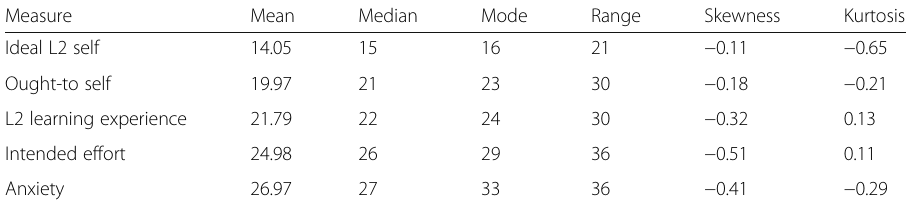
Table 2 Report of mean, median, mode, range, skewness, and kurtosis Measure Ought-to self Intended